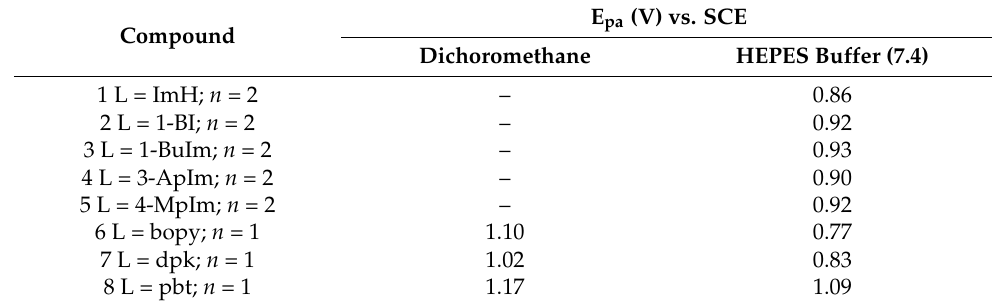
Table 2. Electrochemical data for complexes [Ru( η 5 -C 5 H 5 )(mTPPMSNa) n (L)] [CF 3 SO 3 ] ( n = 1,2) in dichloromethane and HEPES buffer. (SCE = saturated calomel electrode).